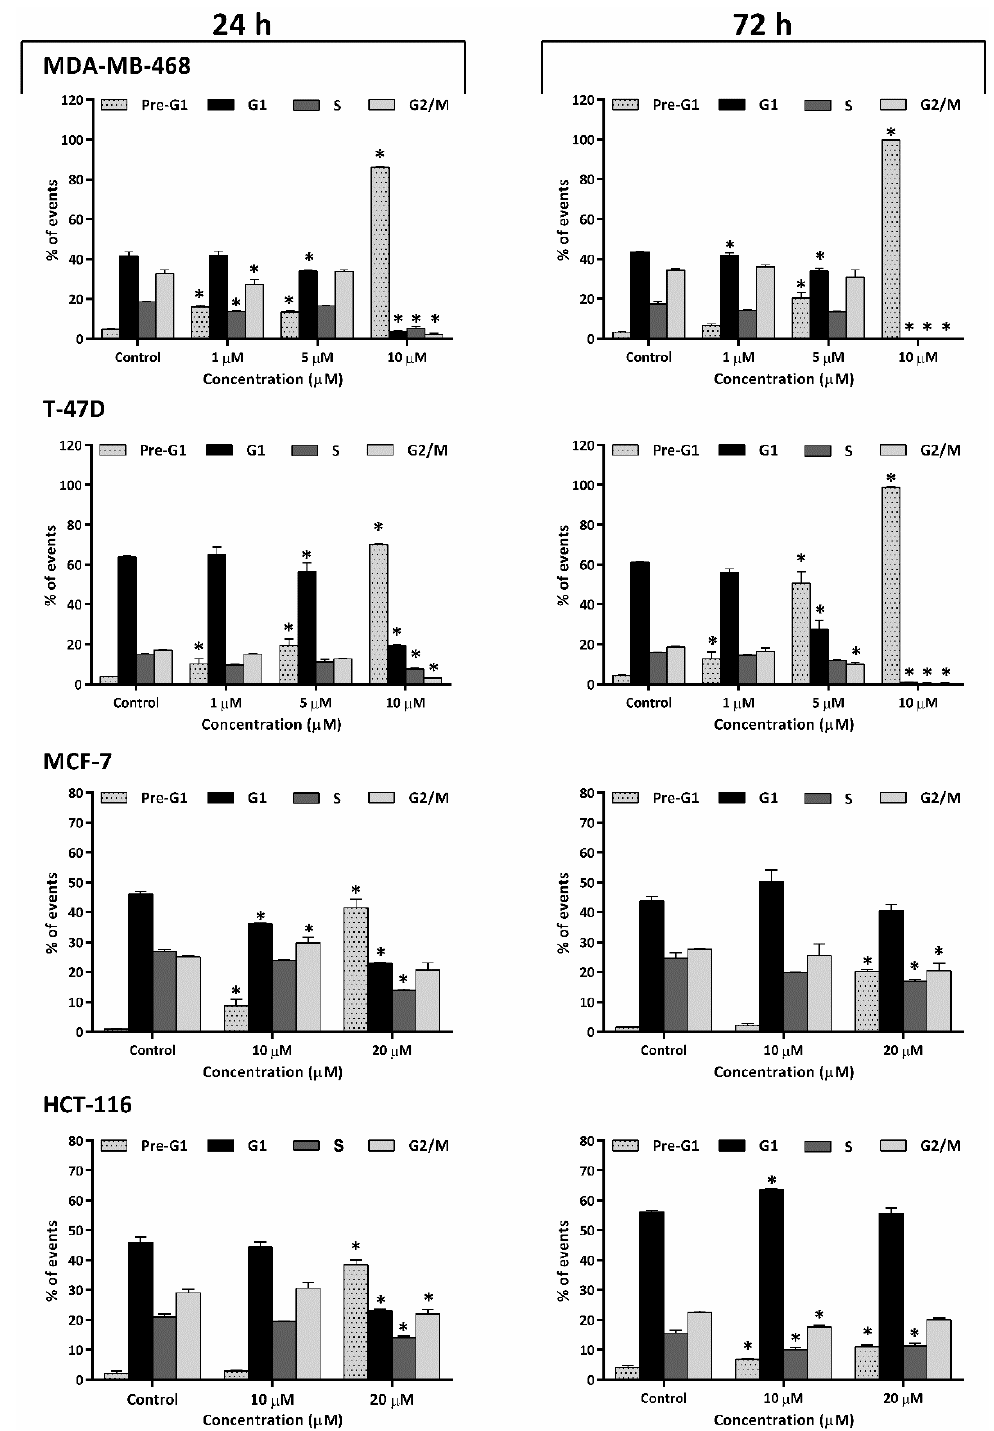
Figure 3. Mean ± SD bars showing % events distribution of MDA-MB-468 T-47D, MCF-7, and HCT-116 cell-cycles after 24, 72 h TQ exposures. MDA-MB-468 and T-47D treated with 1, 5, 10 µM TQ, and MCF-7 and HCT-116 treated with 10, 20 µM TQ. In former cells, TQ induced a significant concentration- and time-dependent increase in pre-G1 (<2N), with decreases in other cell-cycle phases. In the latter cells and after 24 h, TQ also induced a significant concentration-dependent increase pre-G1 (<2N), but after 72 h, fewer pre-G1 events were seen. Cells were treated, then stained with PI, and ≥20,000 events/sample were analysed. Asterisks indicate significant ( p ≤ 0.05) changes compared to control. No. trials ≥3; n = 2 per independent experiment.